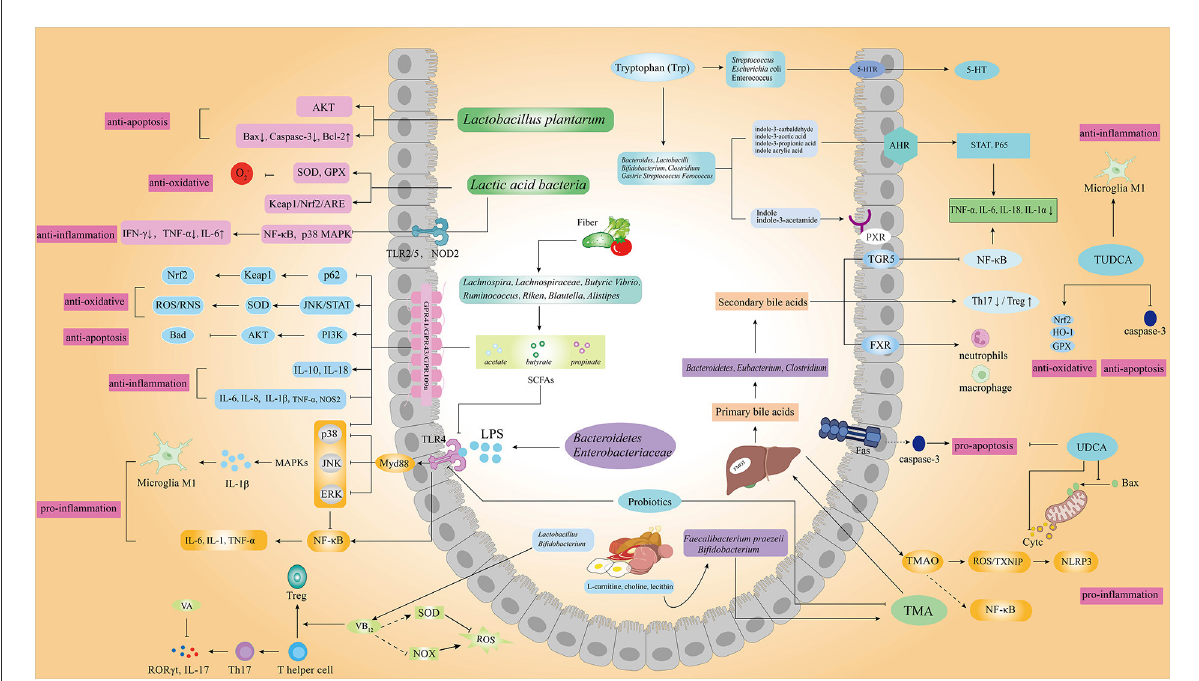
FIGURE2 Gut microbiota and its metabolic products associated with IS. Gut microbiota and the metabolism of SCFAs, tryptophan, bile acids, TMAO, LPS, and vitamins play important roles in oxidative stress, inflammation, and apoptosis of IS through different signaling pathways. (AKT, protein kinase B; Bax, Bcl2-associated X; Bcl-2, B-cell lymphoma-2; SOD, superoxide dismutase; GPX, glutathione peroxidase; Keapl, kelch-like ECH-associated protein 1; Nrf2, nuclear factor E2 related factor 2; Ub, ubiquitination; ARE, adenylate uridylate-rich element; IFN- γ ,